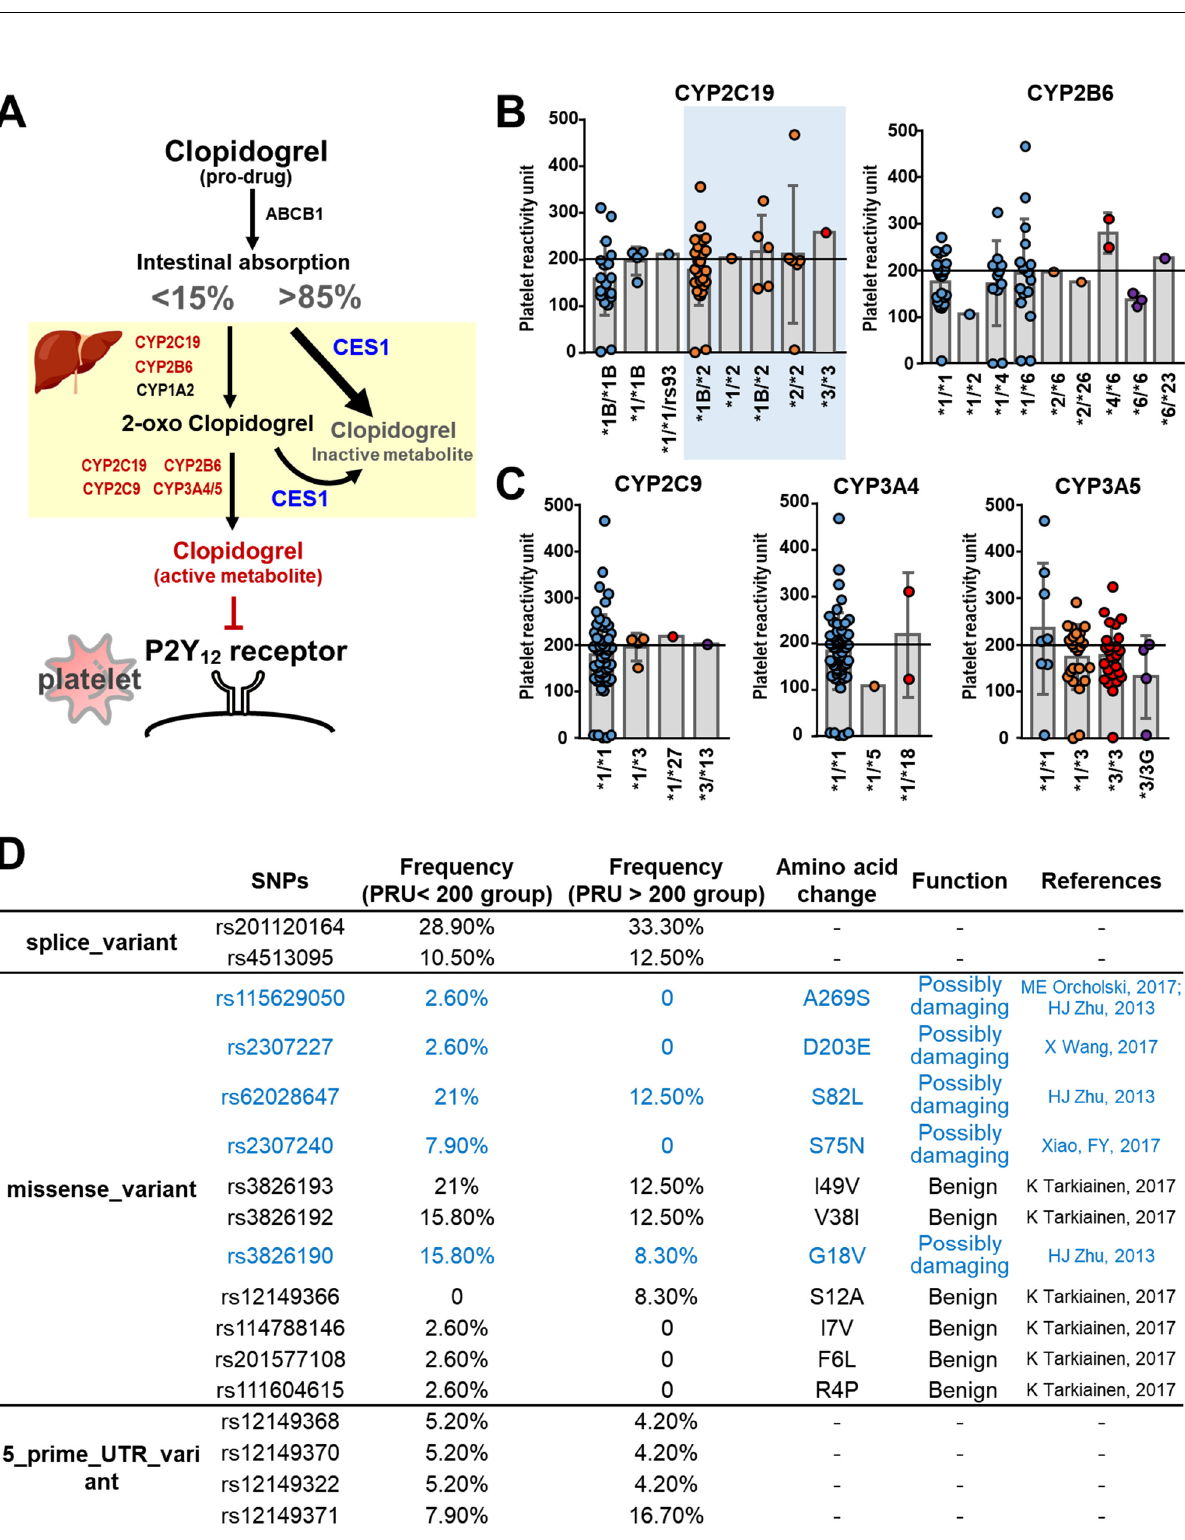
Figure 3. The SNPs in the pathways of clopidogrel metabolism. ( A ) Schematic illustration of the metabolic pathway of clopidogrel and the target receptors on platelets. ( B ) The platelet reactivity unit (PRU) in different genotypes of CYP2C19 and CYP6B6, the key enzymes convert clopidogrel into 2-oxo clopidogrel. ( C ) The PRU in different genotypes of CYP2C9 and CYP3A4/5, the key enzymes convert 2-oxo clopidogrel into activated form of clopidogrel. ( D ) The single-nucleotide polymorphisms (SNPs) of carboxylesterase 1 (CES1) and their functions. The figure is created with